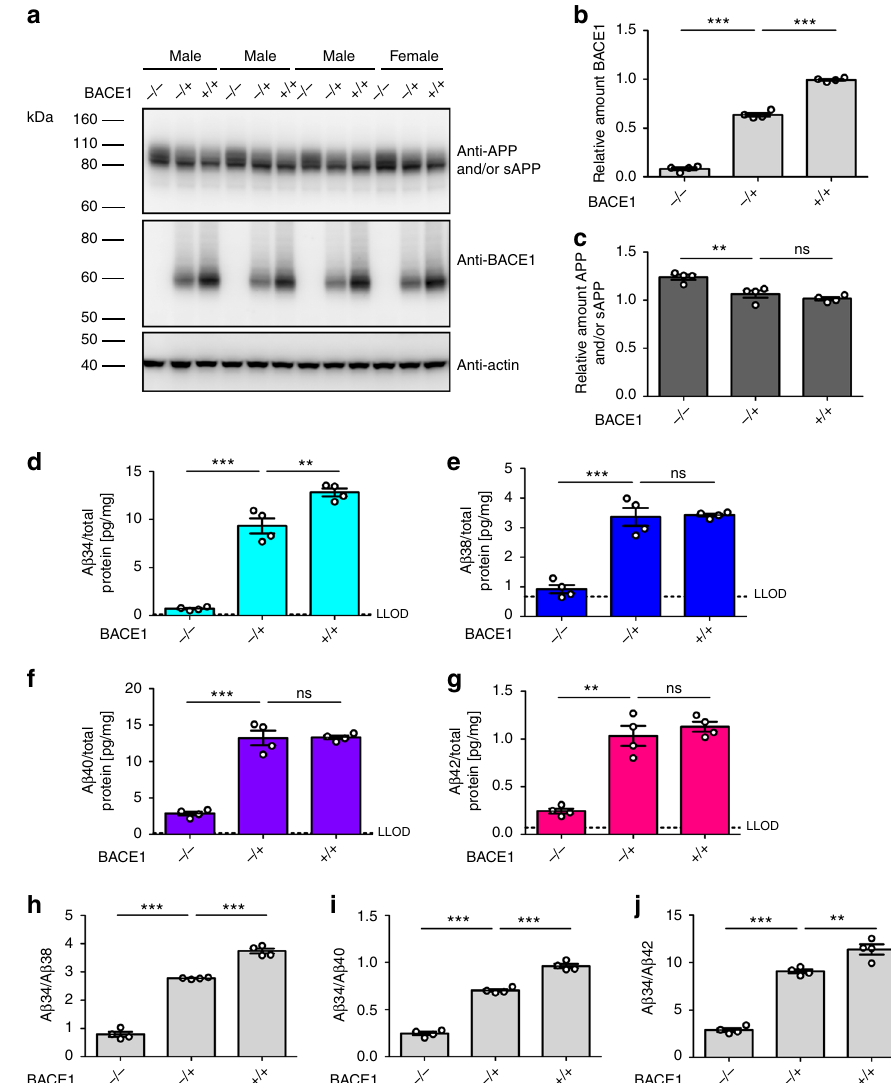
Fig. 1 Endogenous BACE1 generates A β 34 in the murine brain. Endogenous levels of murine APP and/or sAPP, BACE1, and A β in BACE1 − / − , BACE1 + / − , and wild-type littermates ( + / + ). N = 4 animals per group. Western blot of endogenous APP and/or sAPP and BACE1 expression in male and female mice ( a ) and corresponding quanti fi cation of relative protein amounts of BACE1 ( b ) and APP and/or sAPP ( c ). Quanti fi cation (pg/mg total protein) of absolute amounts of A β 34 ( d ), A β 38 ( e ), A β 40 ( f ), and A β 42 ( g ) as determined by custom 4-plex MSD multiplexing assays. Ratios of A β 34/A β 38 ( h ), A β 34/A β 40 ( i ), and A β 34/A β 42 ( j ) are displayed. Statistics: b one-way ANOVA, F (2, 9) = 1021, p < 0.0001, c one-way ANOVA, F (2, 9) = 17.28, p < 0.001, d one-way ANOVA, F (2, 9) = 145.7, p < 0.0001, e one-way ANOVA, F (2, 9) = 53.68, p < 0.0001, f one-way ANOVA, F (2, 9) = 95.65, p < 0.0001, g one-way ANOVA, F (2, 9) = 49.70, p < 0.0001, h one-way ANOVA, F (2, 9) = 425.2, p < 0.0001, i one-way ANOVA, F (2, 9) = 378.0, p < 0.0001, j one-way ANOVA, F (2, 9) = 157.6, p < 0.0001. Bars and error bars indicate mean ± s.e.m. Tukey ’ s post-hoc tests were performed for pairwise comparisons; selected comparisons are highlighted *** p < 0.001, ** p < 0.01, ns = nonsigni fi cant p > 0.05. For each target, the MSD software computes the lower limit of detection (LLOD) as 2.5 standard deviations above the